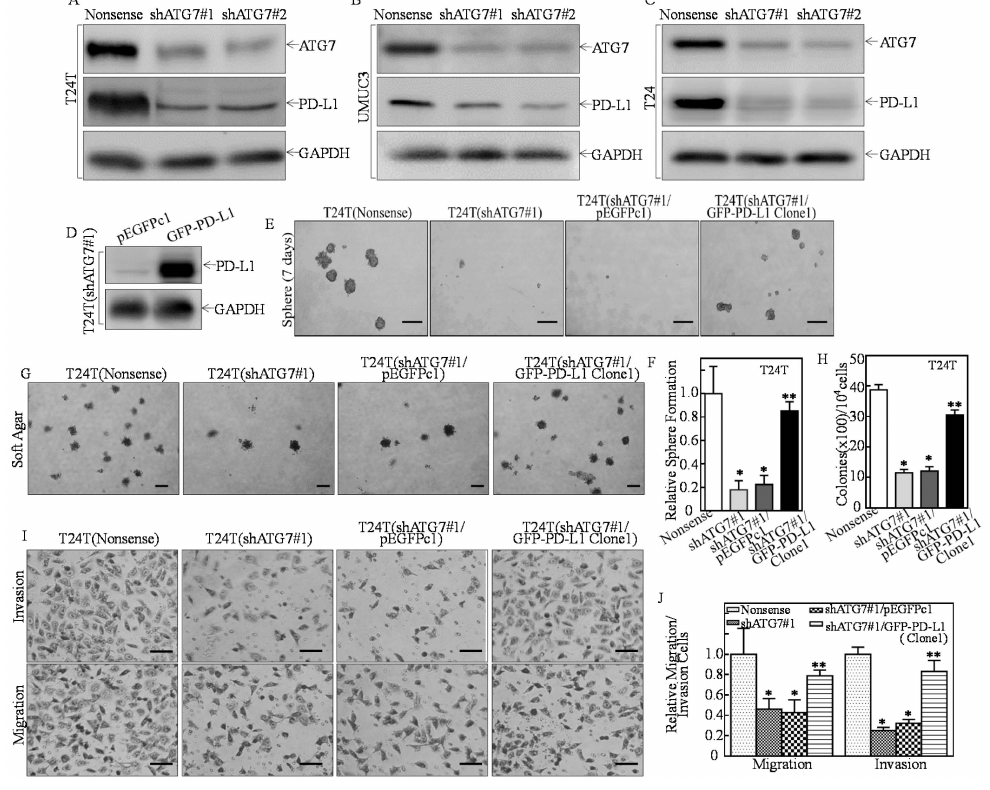
Figure 1. PD-L1 acted as an ATG7 downstream mediator being responsible for ATG7-promoted stem-like property, invasion, and anchorage-independent growth in human high invasive BC cells. ( A – C ) T24T, UMUC3, T24 cells were stably transfected with ATG7 knockdown constructs (#1 & #2), respectively. Western Blot was used to assess the ATG7 protein knockdown efficiency and its effects on other protein expression. ( D ) The GFP-tagged PD-L1 overexpression plasmid was stably transfected into T24T(shATG7#1) cells. ( E , F ) The indicated cells were subjected to determination